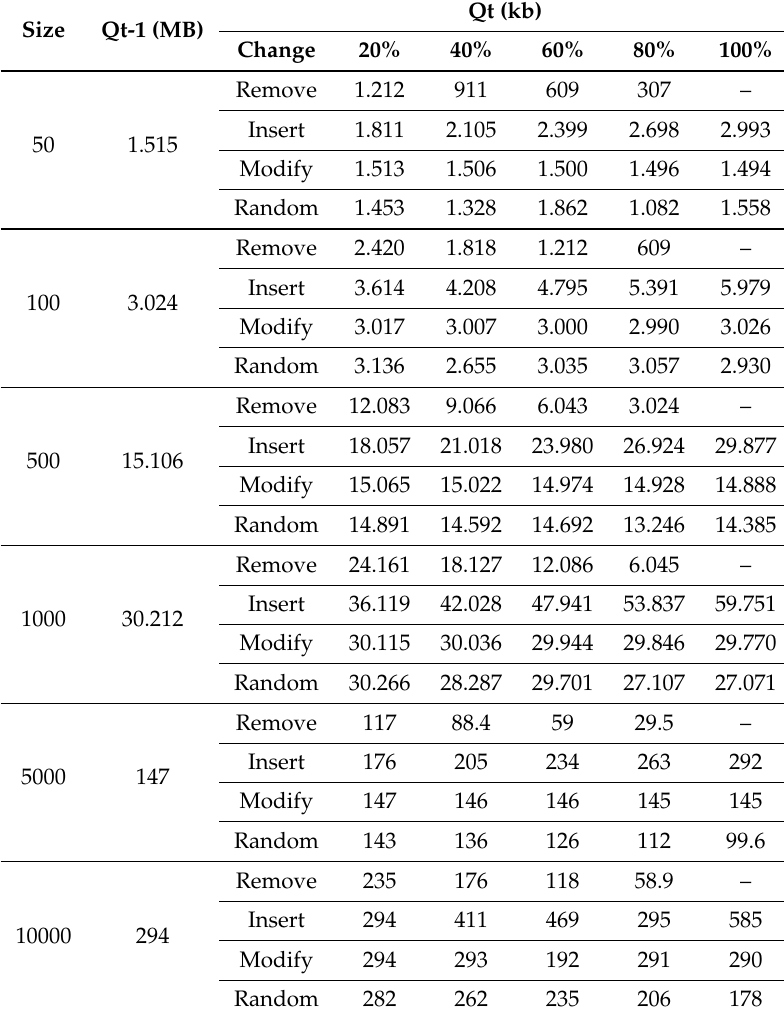
Table A2. The Data Model sizes in MegaBytes (MBs) for